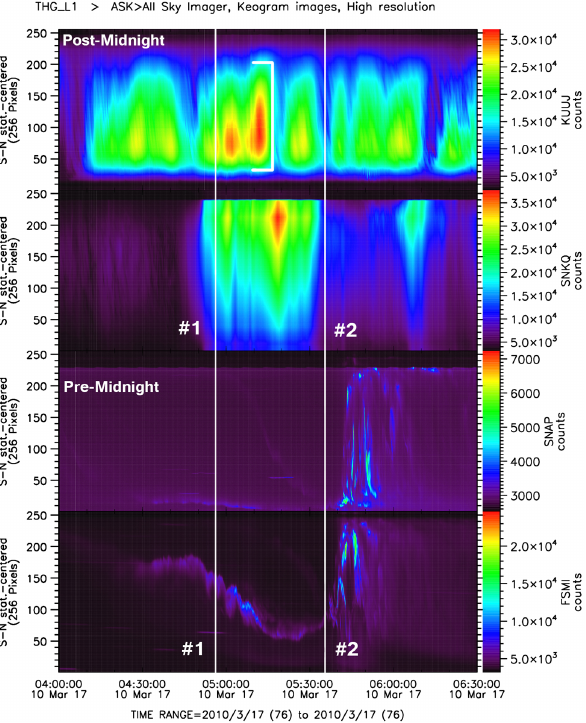
Figure 9. THEMIS ground-based all sky imager (ASI) observa- tions. From top to bottom: Keograms of post-midnight stations KUUJ and SNKQ and pre-midnight stations SNAP and